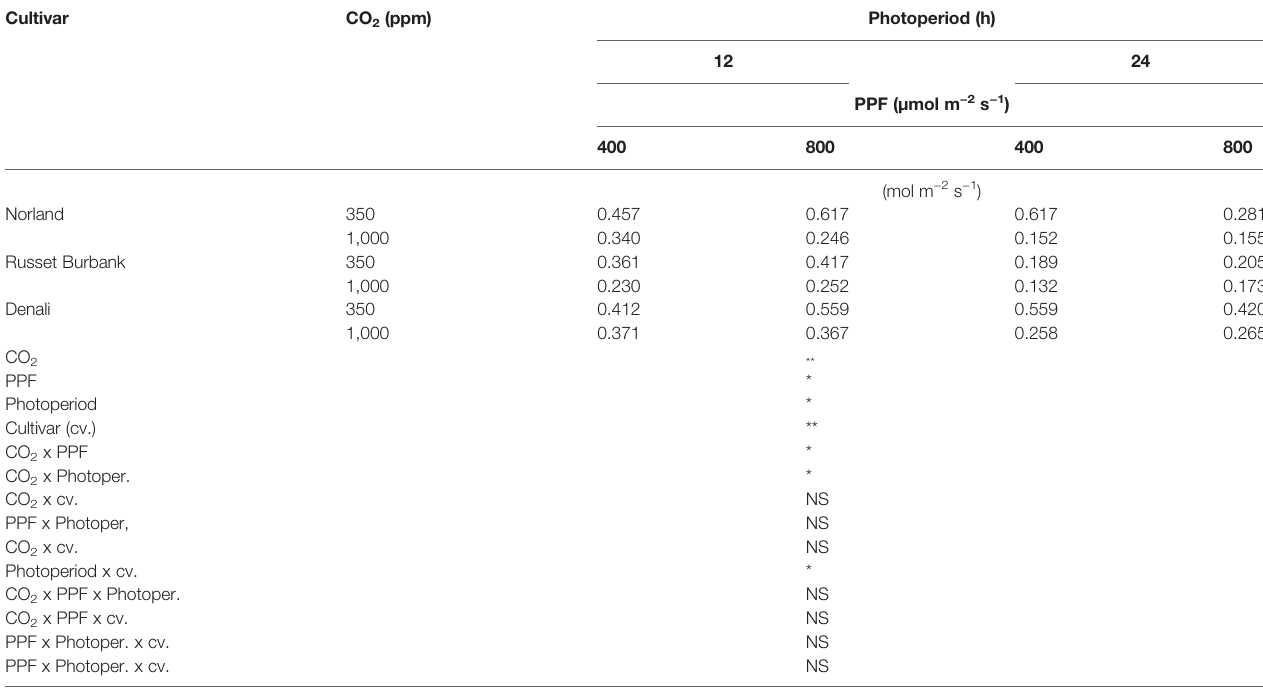
TABLE 4 | Stomatal conductance rates of potato leaves under different photoperiods, CO 2 , and photosynthetic photon fl ux levels (70 days after planting). Cultivar